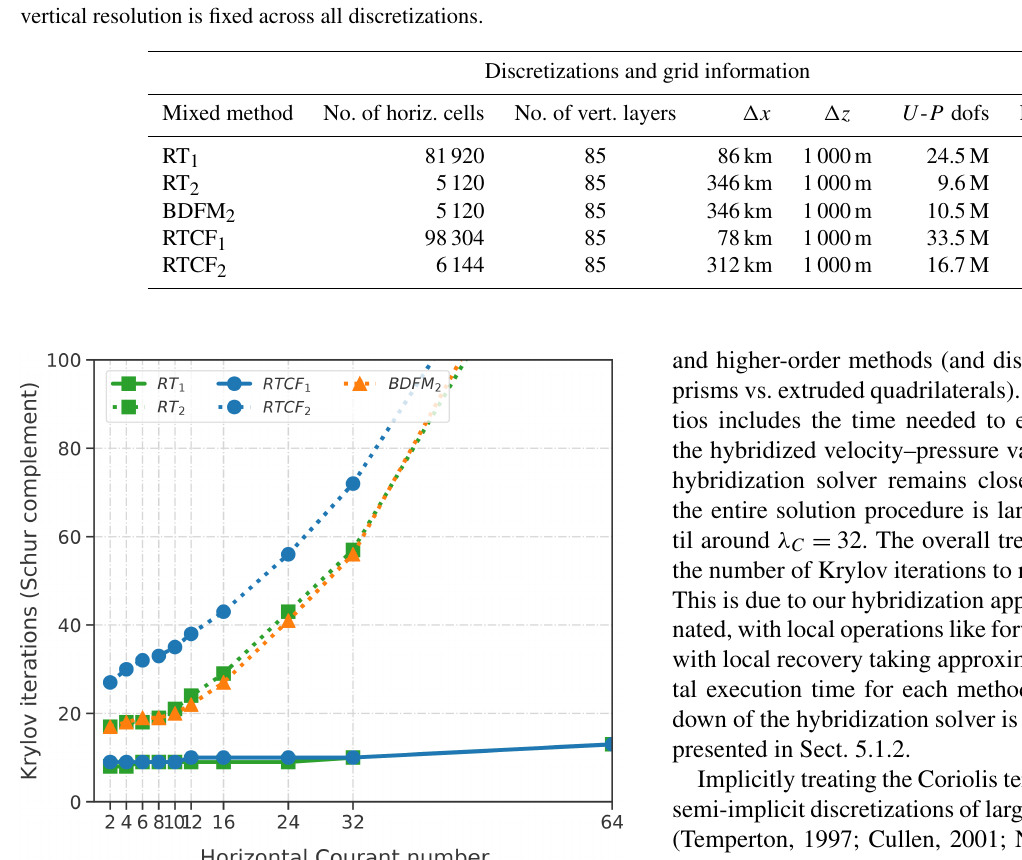
Table 6. Grid setup and discretizations for the acoustic Courant number study. The total number of degrees of freedom (dofs) for the mixed (velocity and pressure) and hybridizable (velocity, pressure, and trace) discretizations are shown in the last two columns (millions). The vertical resolution is fixed across all discretizations.